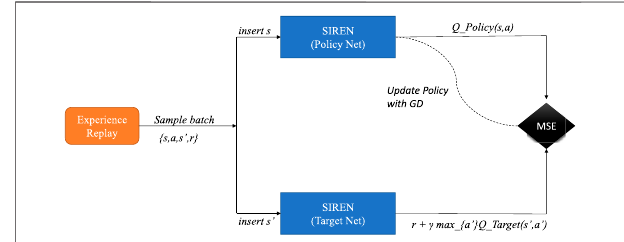
FIGURE 2 | Figure for visualizing the Pipeline of the deep Q learning with SIRENs